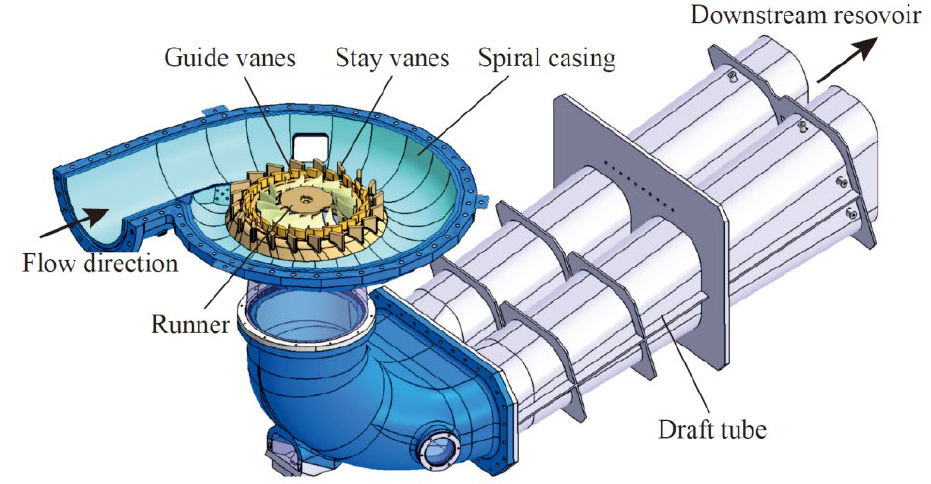
Figure 2. Composition diagram of hydro turbine [14].